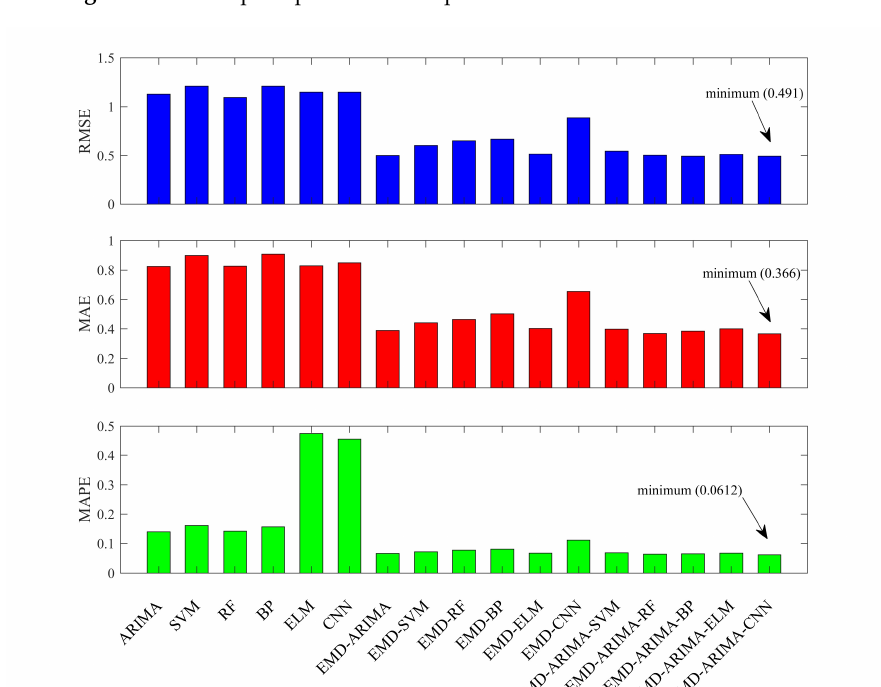
Figure 11. Wind speed prediction comparisons for the 1 h data at the GD